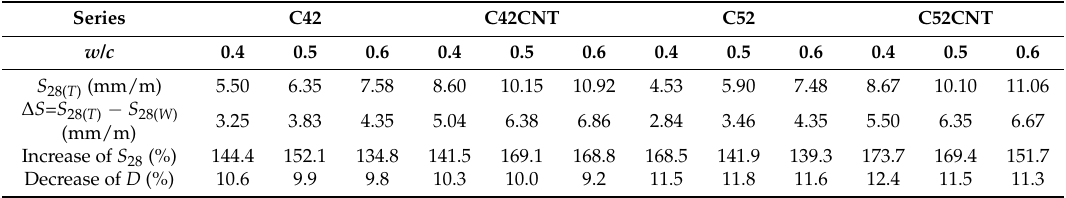
Table 2. The linear shrinkage values of samples tested after thermal load, the percentage increase in shrinkage, and apparent density decrease due to the thermal shock.